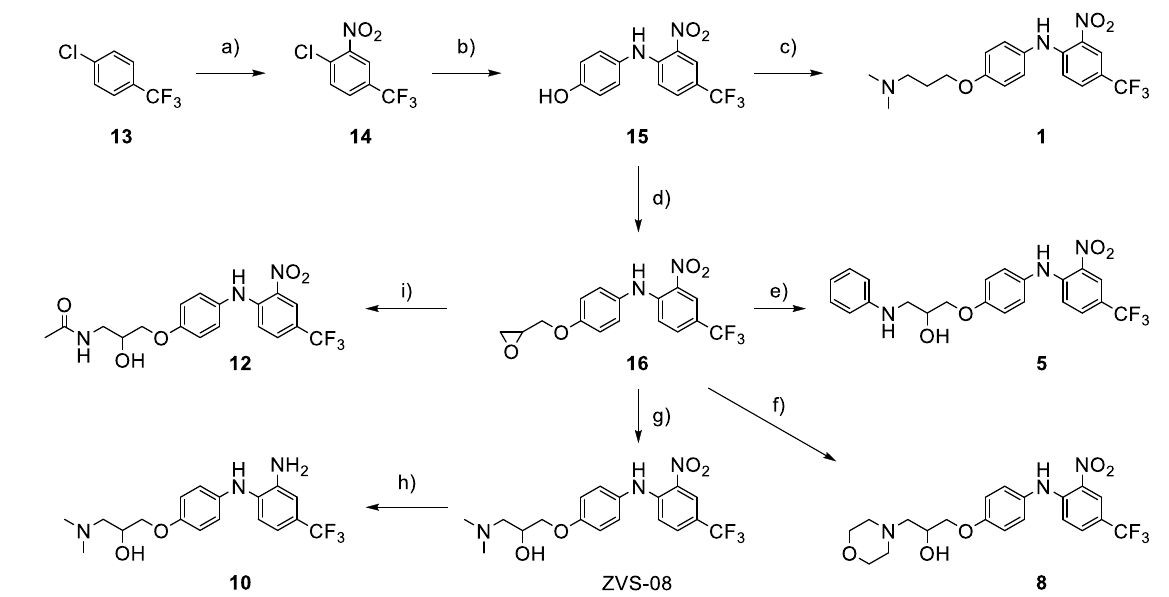
Figure 2. Reagents, solvents and conditions: ( a ) H 2 SO 4 , HNO 3 , 80 °C, 1 week; ( b ) 4-aminophenol, isopropanol, 80 °C, 40 h; ( b ) 4-aminophenol, NaHCO 3 , EtOH, 100 °C, 20 h; ( c ) 3-dimethylamino-1-propyl chloride hydrochloride, Cs 2 CO 3 , DMF, 100 °C, 3 h; ( d ) (±)-epichlorohydrin, MeCN, K 2 CO 3 , 80 °C, 16 h; ( e ) aniline, MeOH, r.t., 40 h; ( f ) morpholine, MeOH, r.t., 36–48 h; ( g ) Me 2 NH × HCl, MeOH, 70 °C, 24 h; ( h ) 20% wt Pd/C, H 2 , MeOH, r.t., 2 h; ( i ) BF 3 OEt 2 , MeCN, 80 °C, 16 h.